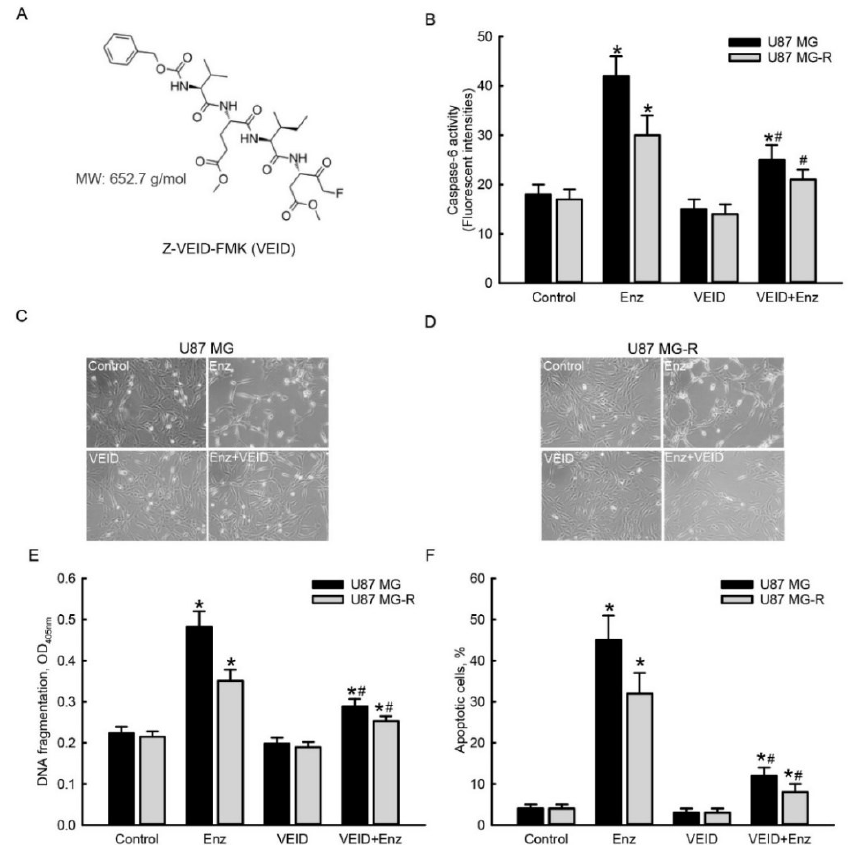
Figure 6. Suppressing caspase-6 activity concurrently attenuated enzalutamide (Enz)-induced DNA fragmentation and apoptotic death of temozolomide (TMZ)-sensitive U87 MG and TMZ-resistant U87 MG-R glioblastoma cells. The chemical structure of Z-VEID-FMK (VEID), a specific inhibitor of caspase-6, with a molecular weight of 652.7 g/mol is shown in ( A ). Human U87 MG and U87 MG-R glioblastoma cells were pretreated with 50 µ M VEID for 1 h and then exposed to 50 µ M Enz for 72 h. The activity of caspase-6 was assayed using a fluorogenic substract method ( B ). Cell morphologies were observed and photographed using a microscope ( C , D ). DNA fragmentation was quantified using an ELISA method ( E ). Apoptotic cells were analyzed using flow cytometry ( F ). Each value represents the mean ± SEM for n = 6. The symbols * and # respectively indicate that the values significantly ( p < 0.05) differed from the control and Enz-treated